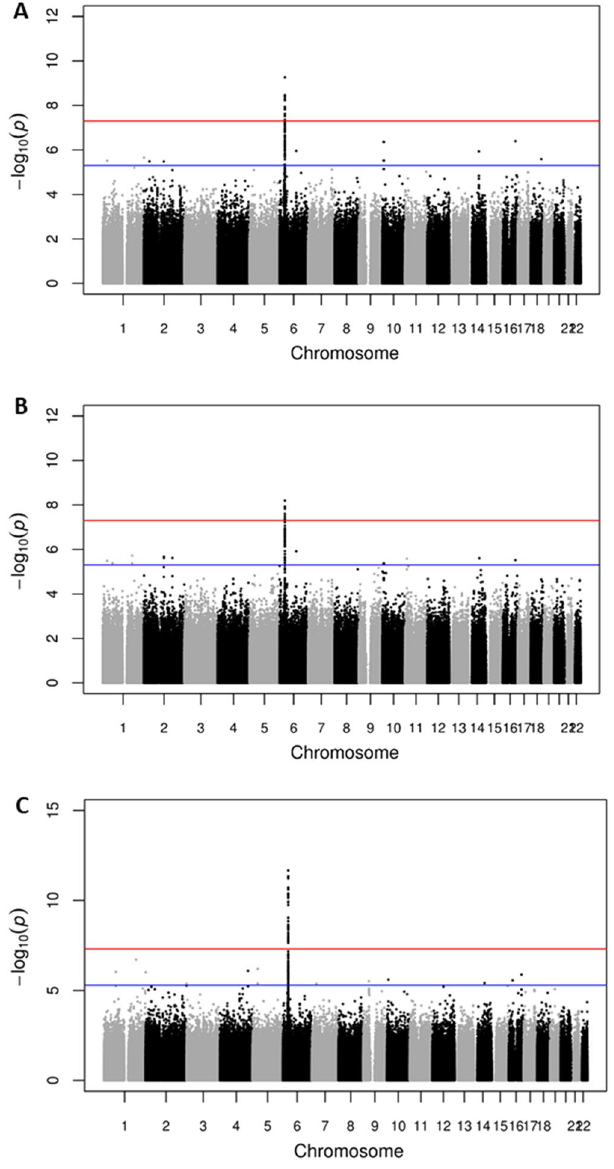
Figure 2. Manhattan plots showing genome-wide association with podoconiosis in Ethiopia. ( A ) dataset 1 comprising combined new samples from the Amhara, Oromo and Wolaita ethnic groups; (N = 1892, 943 cases and 949 controls); ( B ) dataset 2 from the Amhara and Oromo ethnic groups (N = 1511, 752 cases and 759 controls) and ( C ) dataset 3 comprising all available samples i.e. dataset 1 plus the samples from the previously- published podoconiosis GWAS undertaken in the Wolaita group (N = 2289,1137 cases and 1152 controls). For each plot, the x-axis indicates chromosomal position and the y-axis indicates the − log10 P value. Points between the blue and red lines shows suggestive association ( P < 5.0 × 10 −7 ) whereas points above the redline shows genome-wide significance ( P < 5.0 × 10 −8 ) results. The R programme was used to generate the plots 48